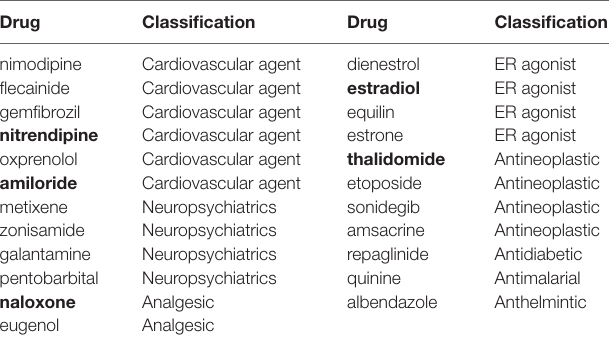
TABLE 4 | Final candidate drugs for ISCM.